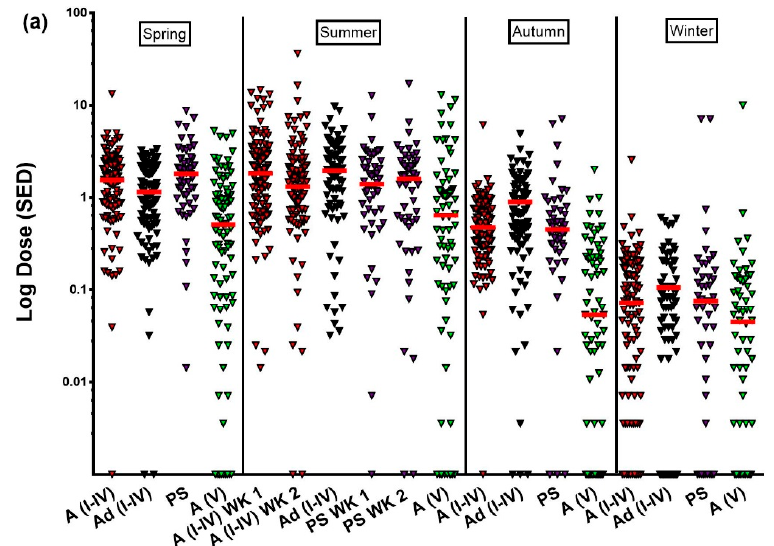
Table 3. Percentage of skin surface area exposed during study